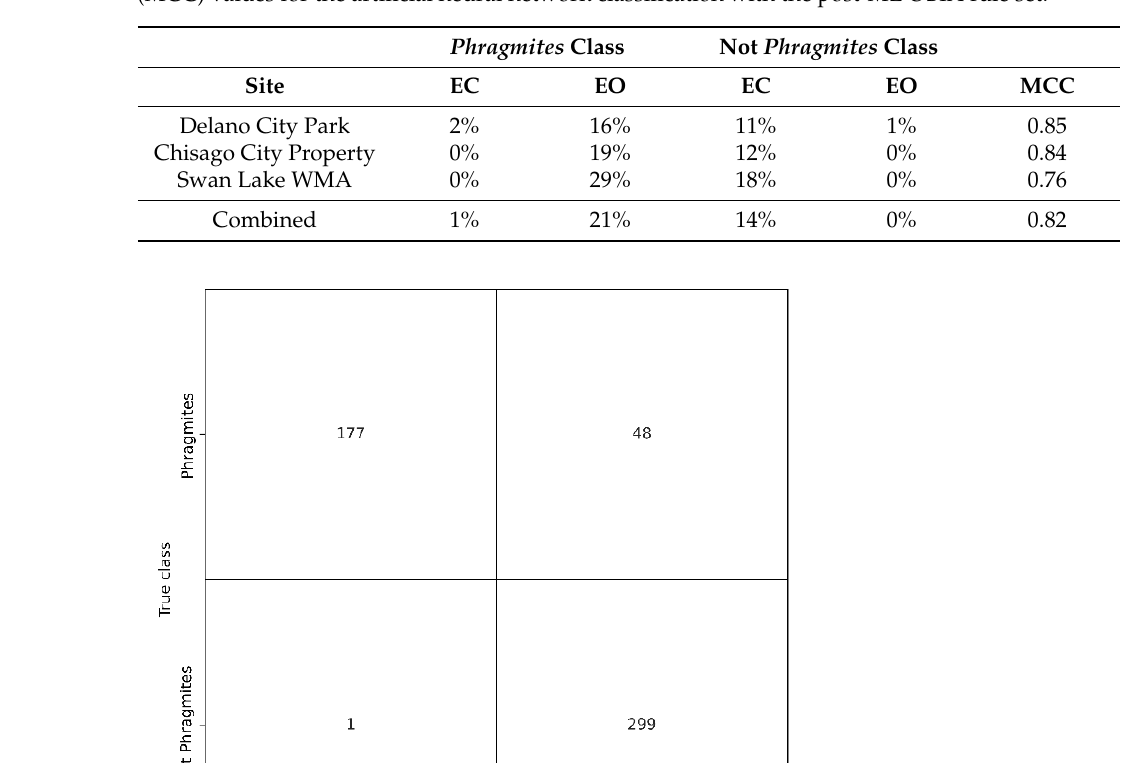
Table 13. Errors of commission (EC), errors of omission (EO), and Matthews correlation coefficient (MCC) values for the artificial neural network classification with the post-ML OBIA rule set.